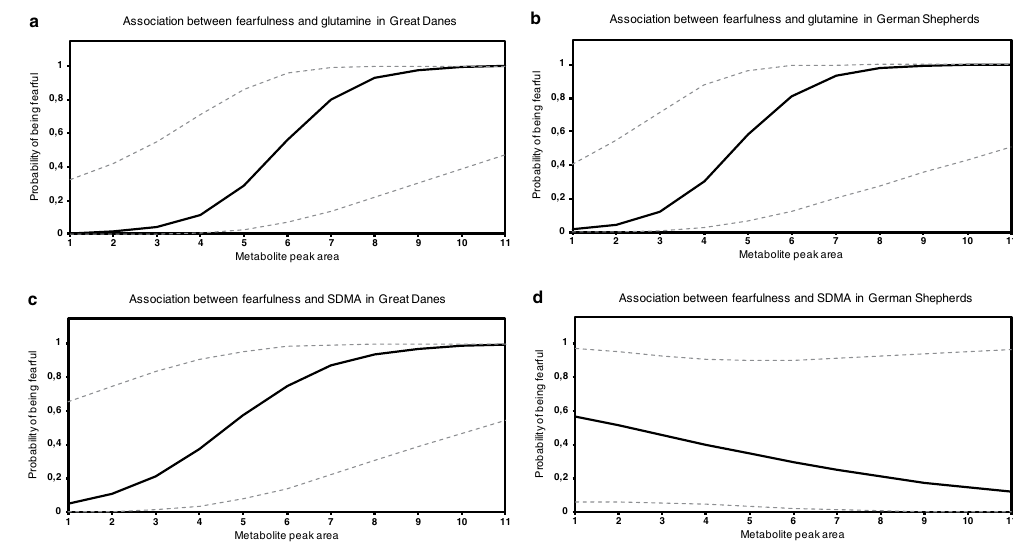
Figure 5. Effects of glutamine and SDMA peak areas on fearfulness in Great Danes and German Shepherds. ( a ) Association between glutamine peak area and fearfulness in Great Danes. The higher the glutamine amount is, the higher is the dog’s probability of being fearful when the dog is Great Dane. ( b ) Association between glutamine peak area and fearfulness in German Shepherds. The higher the glutamine amount is, the higher is the dog’s probability of being fearful when the dog is German Shepherd. ( c ) Association between SDMA peak area and fearfulness in Great Danes. The higher the SDMA amount is, the higher is the dog’s probability of being fearful when the dog is Great Dane. ( d ) Association between SDMA peak area and fearfulness in German Shepherds. SDMA has a slight, non-significant negative association with fearfulness when the dog is German Shepherd. Dashed lines indicate 95% confidence limits. SDMA, symmetric